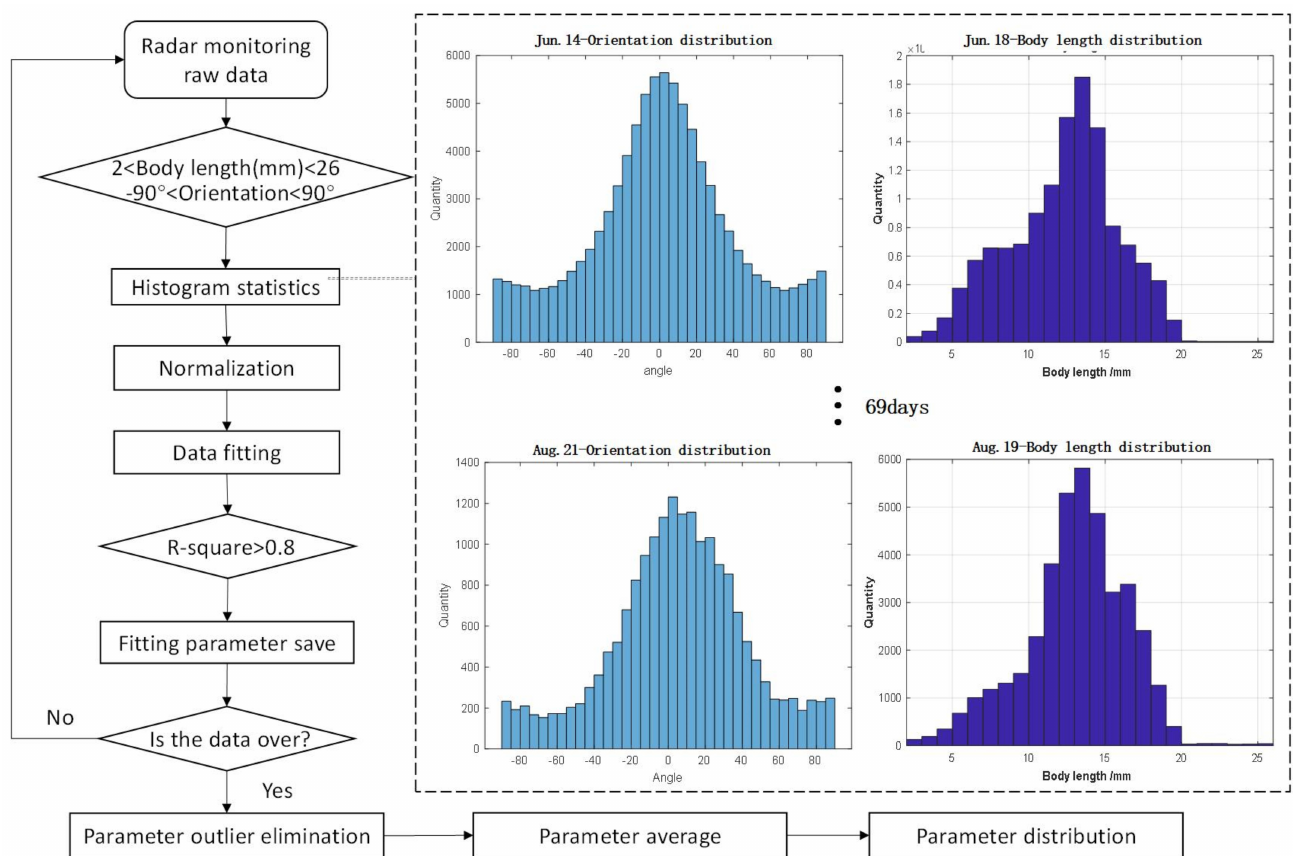
Figure 5. Flow chart of insect parameter distribution model acquisition